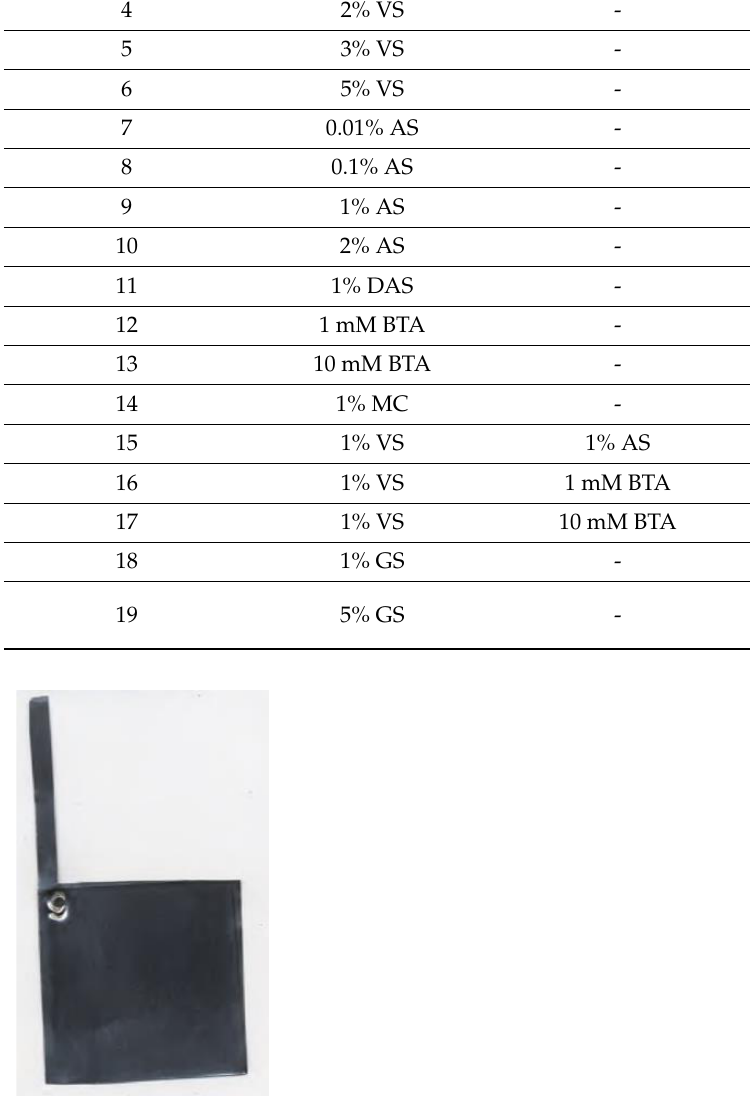
(0.4 M H 3 BO 3 + 5.5 mM Na 2 B 4 O 7 × 10H 2 O, pH 6.7). A platinum electrode with an